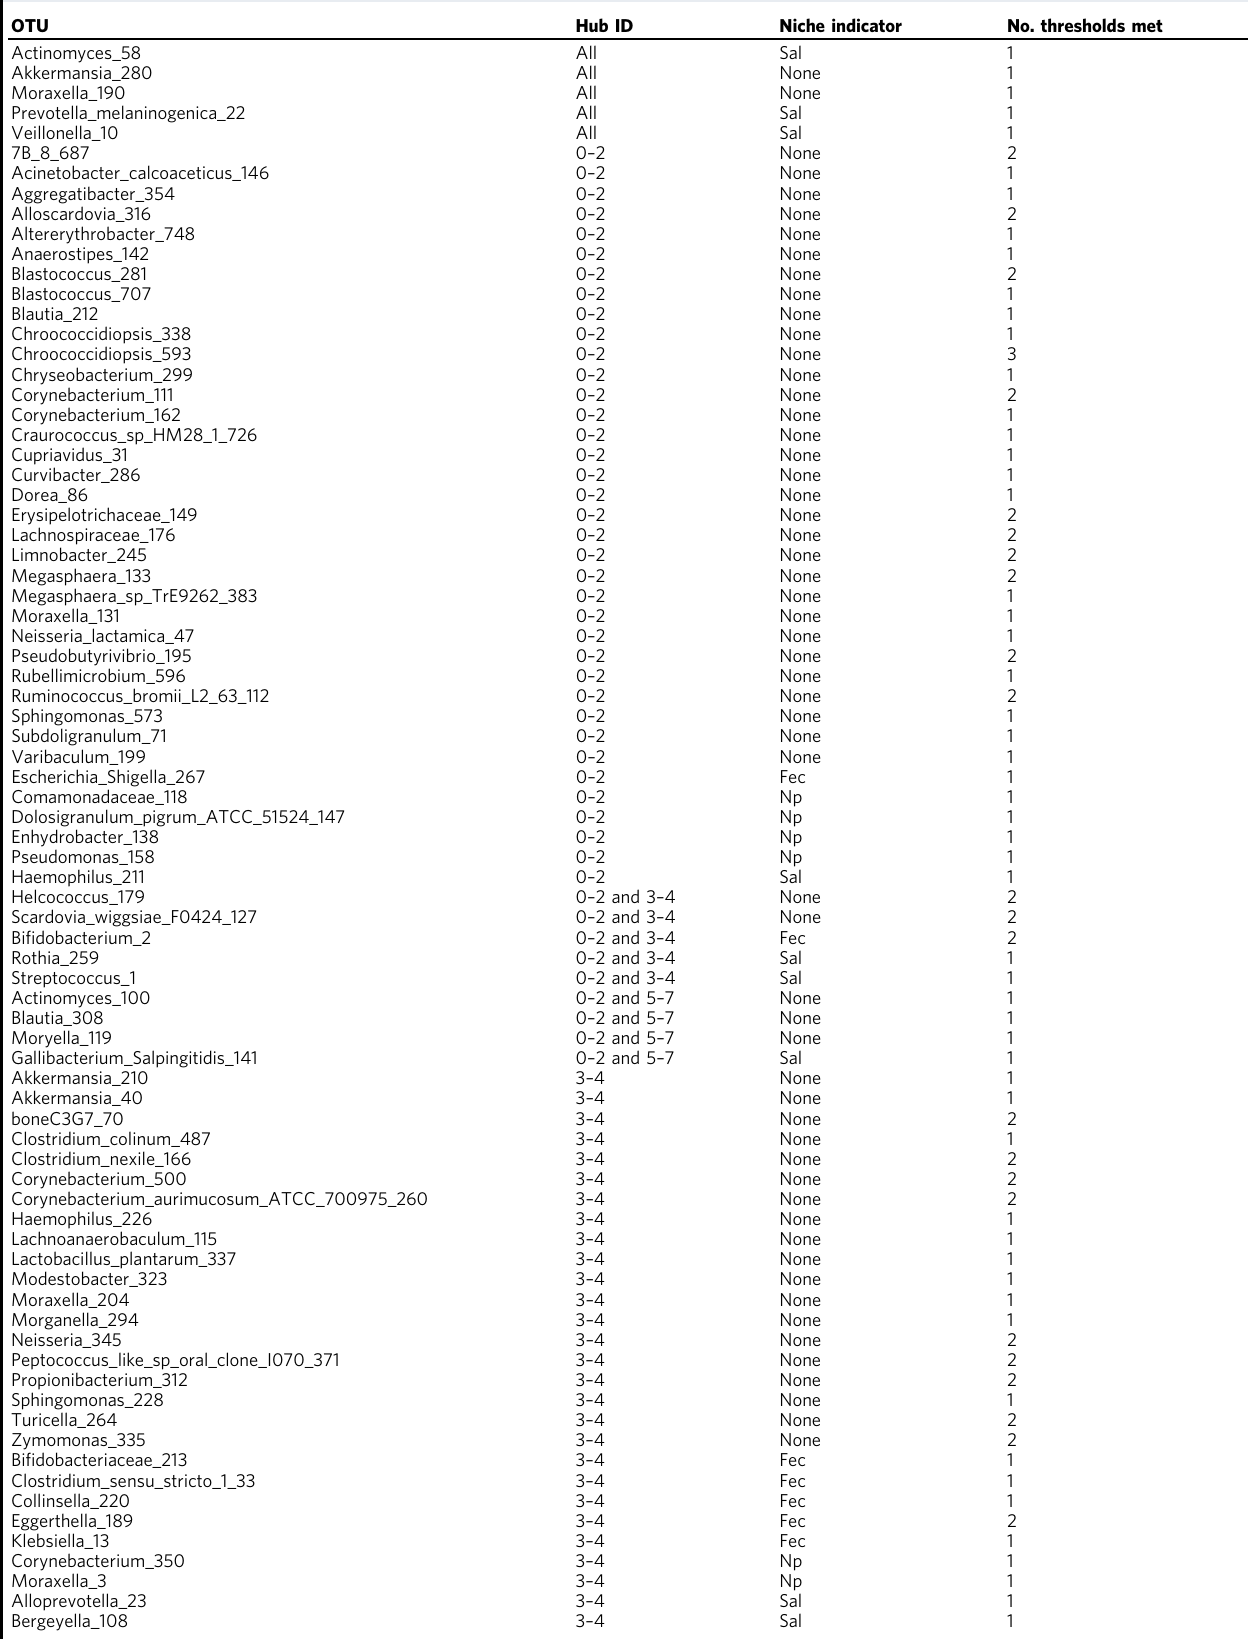
Table 1 Hub species for all RTI cohorts.